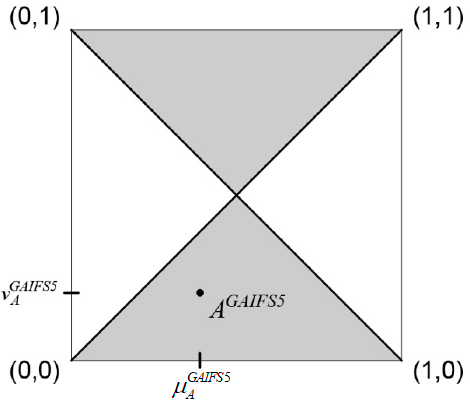
Figure 3. Interpretational surface of generalized IFS in the sense of GAIFS5.